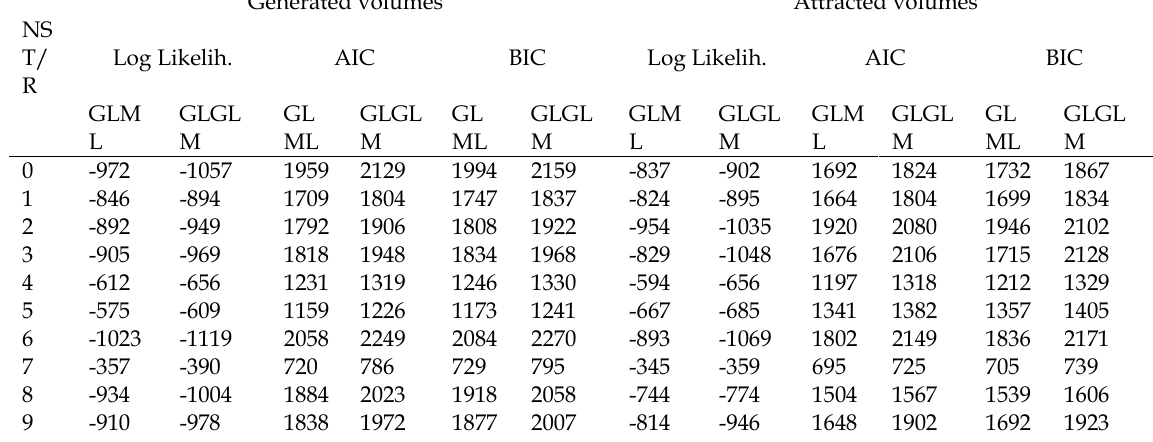
Table 4. AIC values, BIC values and log likelihood for generated and attracted volumes following the GLML and the GLGLM